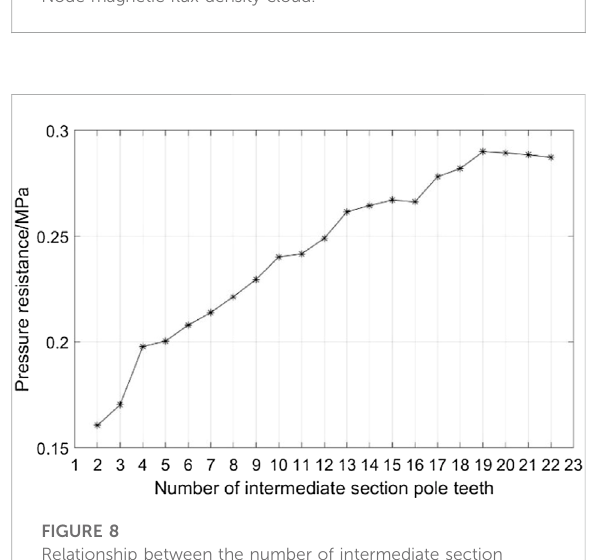
FIGURE 5 Delineate the grid and load the boundary conditions.